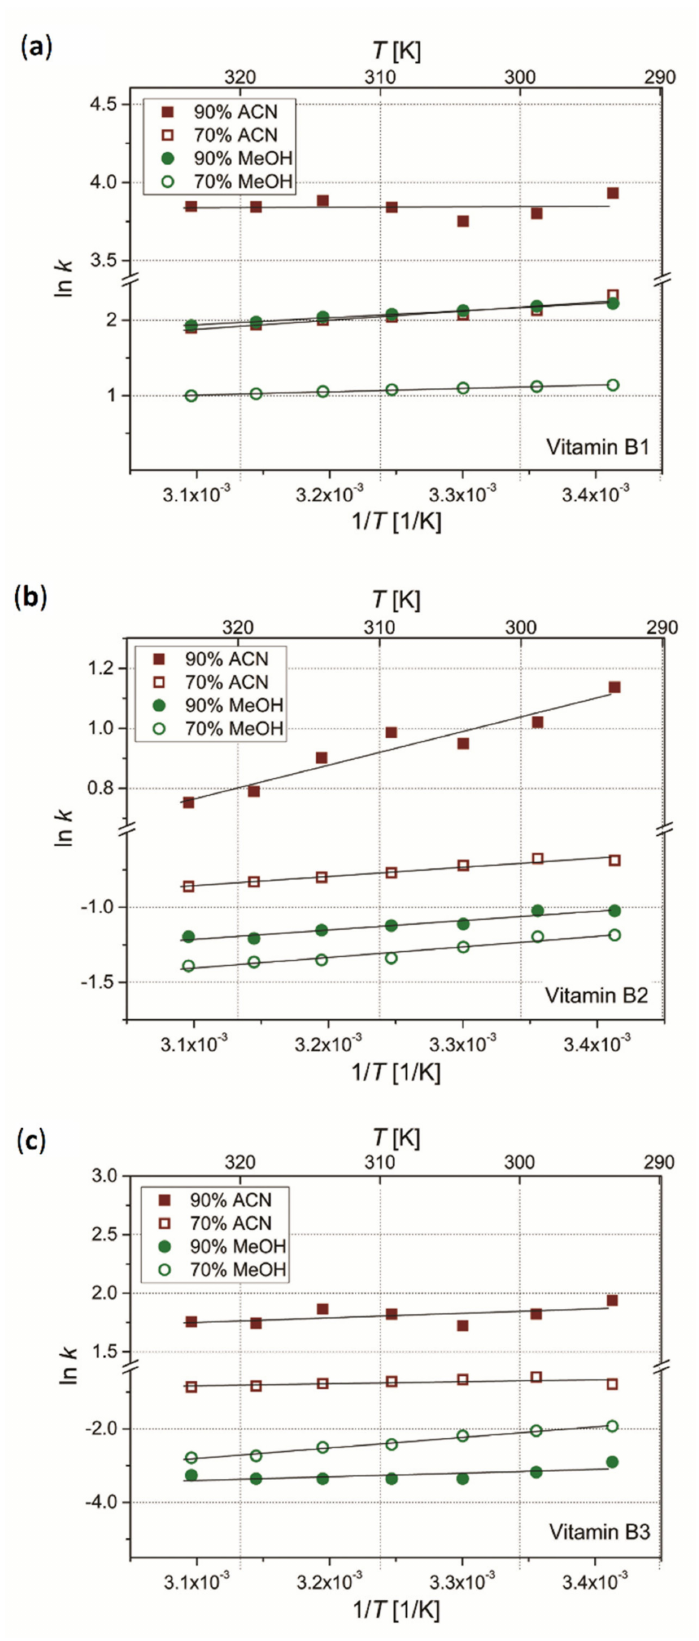
Figure 5. Effect of temperature on retention coefficient of: ( a ) vitamin B1, ( b ) vitamin B2 and ( c ) vitamin B3 in column E (Eurospher II 100–5